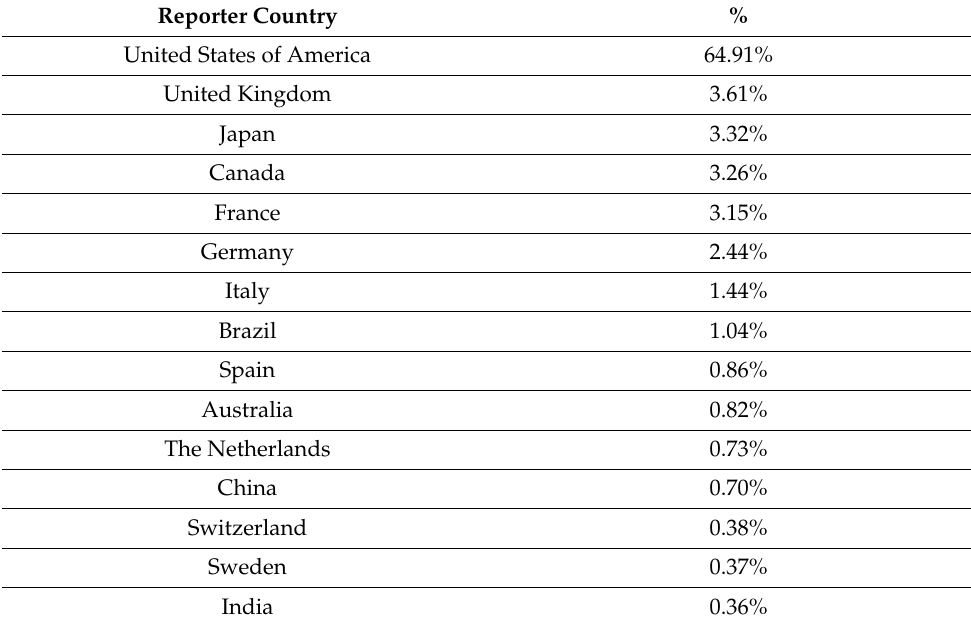
Table 1. Top 20 reporting countries to FAERS/LAERS database in descending